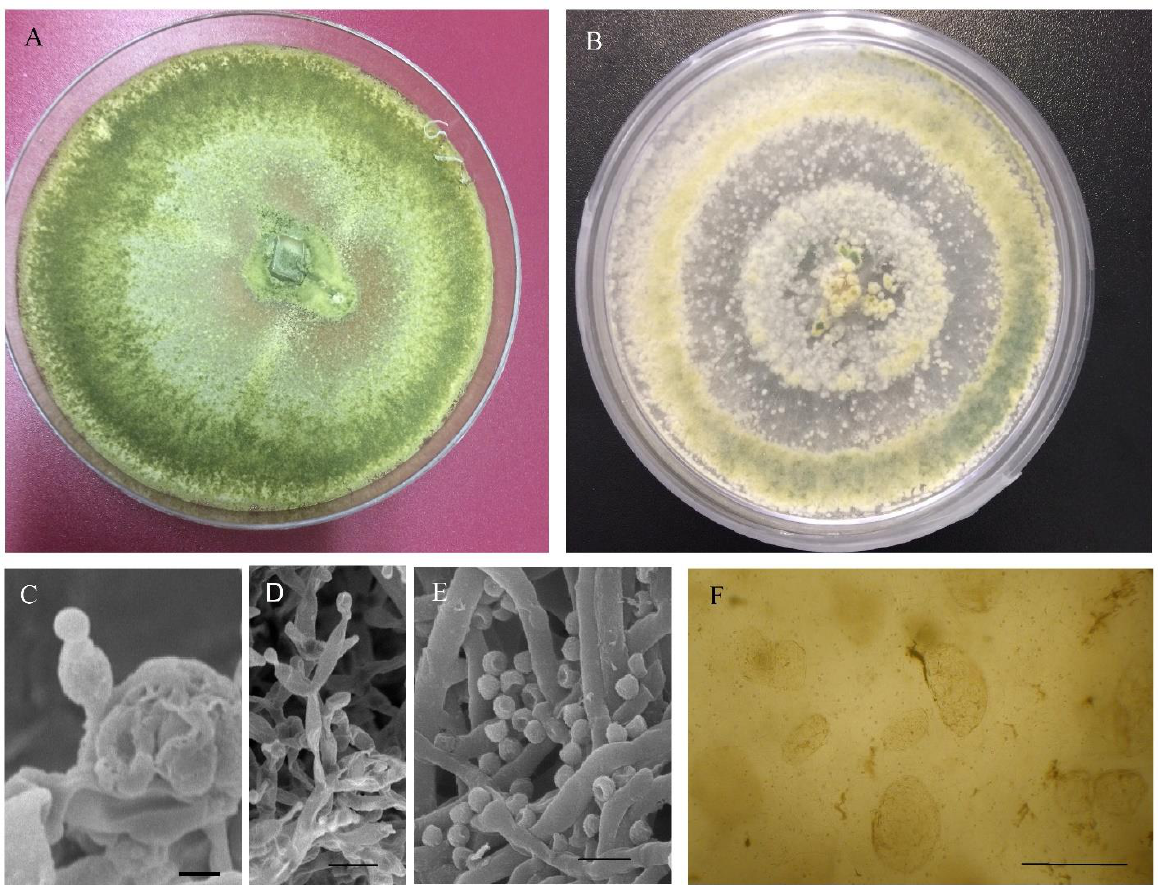
Figure 1. Colonies of T. harzianum in a PDA medium (5 d, 25 °C). Obverse of plate ( A , B ); SEM micrographs of phialides ( C ), bar = 2 µm, phialides and conidia ( D ), bar = 5 µm and conidia ( E ), bar = 5 µm; and chlamydospores ( F ), bar = 10 µm.